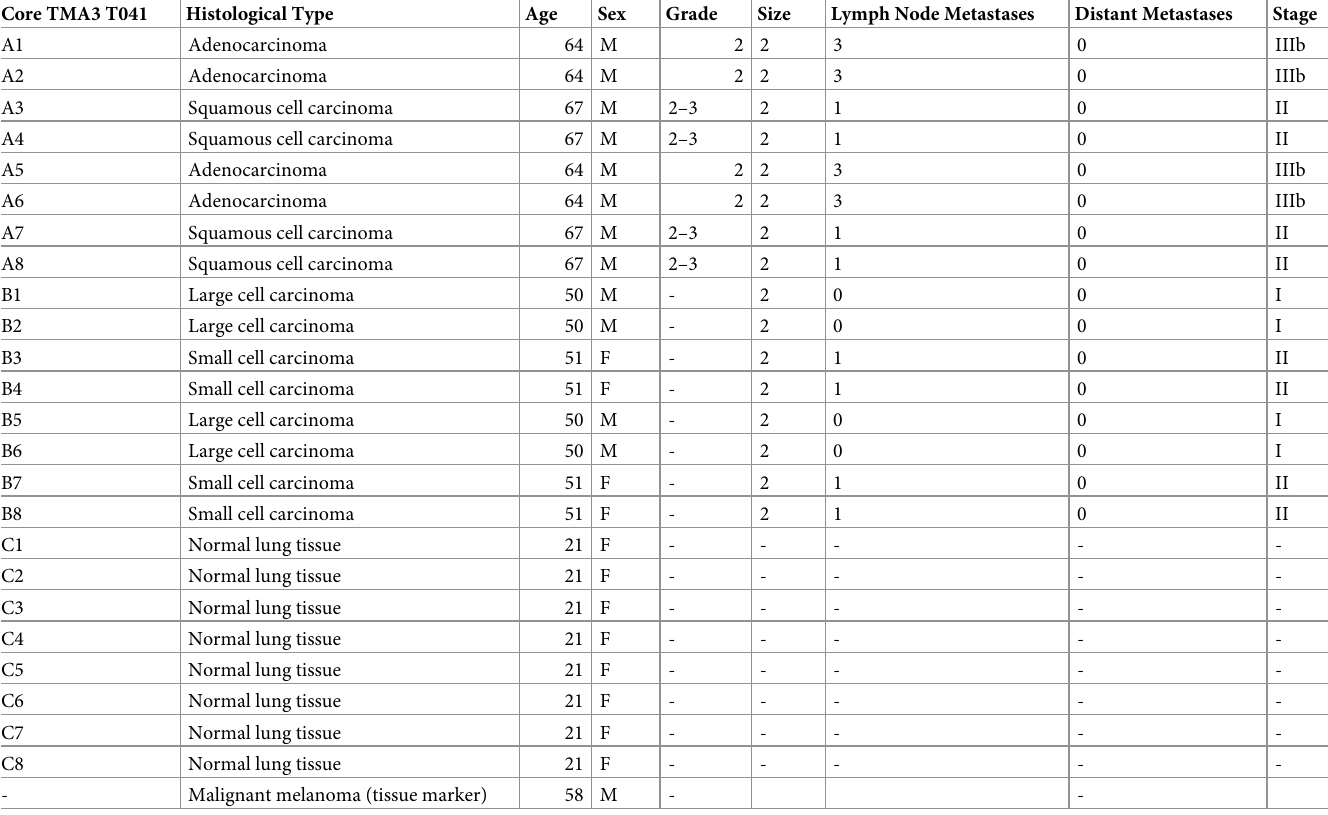
curve is usually classified as a range between 0.5 (no predictive power) and 1.0 (perfect predic- tive accuracy). As can be seen in this table, phospho-Rb S249 score had an area under the curve of 0.7396, while p39 score had an area of 0.9375, both being close to 1.0 and thus indicat- ing a strong predictive value for grading and staging and metastasis, respectively. Phospho-Rb S249 and p39 scores had a sensitivity of 75% and 87.5%, respectively, meaning that 75% of the tumor samples with high phospho-Rb S249 score also had high grading, and 87.5% of the tumor samples with high p39 score had high staging and lymph node involvement and distant metastasis. Regarding specificity, the numbers for the phospho-Rb S249 and the p39 scores were 67.65% and 100%, respectively, meaning that 67.65% of the tumor samples with low scores for phospho-Rb S249 score were also of low grade, while none of the tumor samples negative for p39 were of a higher stage or had metastasis to lymph nodes or distant sites. Table 3. Complete description of TMA